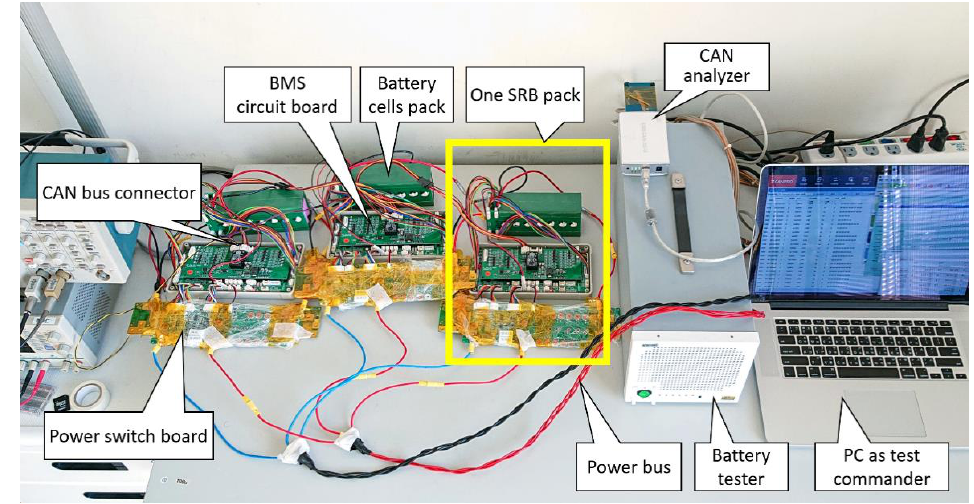
Figure 7. Physical setup of the charging and discharging experiment. The PC commands the battery tester to variate the loading and charging current to the power bus of red and black cables. The CAN bus is connected to the CAN analyzer with the PC emulating ECU/BCC functions and logging the CAN bus messages.